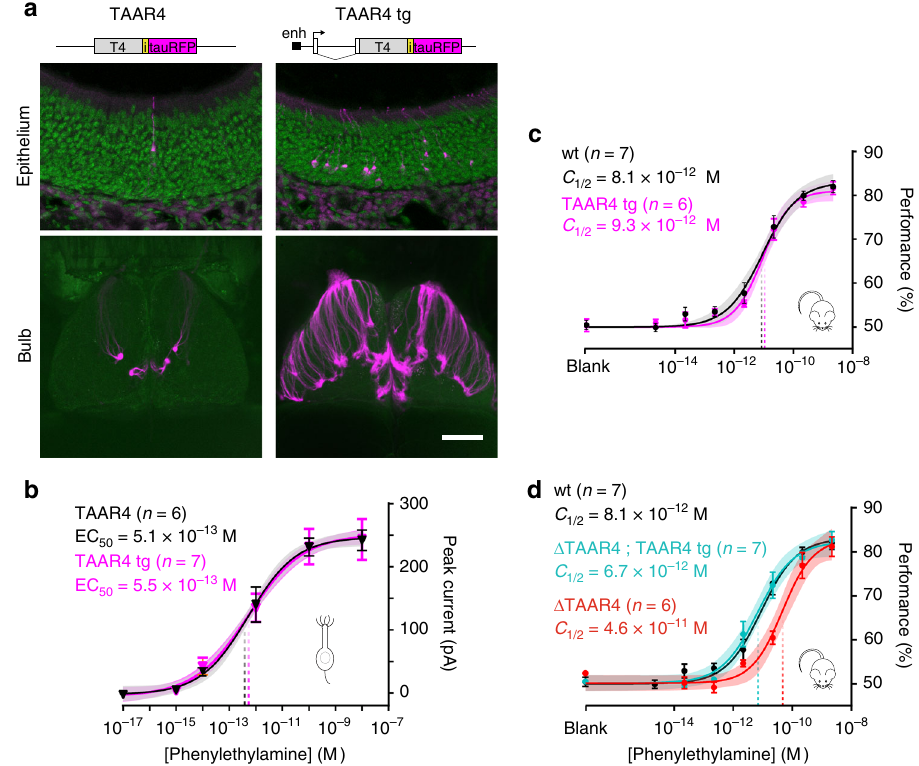
Fig. 6 Overexpression of a threshold-determining TAAR does not enhance behavioral sensitivity. a Top: summary of transgenic strategy showing the control gene-targeted TAAR4 locus and transgene. The M71 transgene was modi fi ed by inserting a 5× homeodomain enhancer (enh) upstream of the transcription start site and by replacing the M71-coding sequence with the TAAR4-coding sequence, an internal ribosome entry site (i), and a fl uorophore (tauRFP). Bottom: Sections of the olfactory epithelium and whole mounts of the olfactory bulb (dorsal view) in TAAR4-RFP and transgenic overexpressing mice. Scale bar is 50 μ m in upper panels and 800 μ m in lower panels. b Dose – response curves of OSN responses to phenylethylamine. Peak inward current was measured from single labeled neurons from TAAR4-RFP (black) and TAAR4 transgenic (magenta) mice. T4-RFP EC 50 = 5.1 × 10 − 13 M (95% CI = 3.0 – 8.3 × 10 − 13 M). 5×21-TAAR4Tg EC 50 = 5.5 × 10 − 13 M (95% CI = 2.5 – 11.6 × 10 − 13 M). c No effect of transgene expression on phenylethylamine sensitivity. Psychometric curves showing behavioral sensitivity ( C 1/2 ) of TAAR4 overexpressing transgenic mice (magenta) and wild-type littermates (black) to phenylethylamine. wt C 1/2 = 8.1 × 10 − 12 M (95% CI: 4.6 – 16.8 × 10 − 12 M), 5×21-TAAR4Tg C 1/2 = 9.3 × 10 − 12 M (95% CI: 6.0 – 15.9 × 10 − 12 M). d Effective transgenic rescue. Psychometric curves showing C 1/2 of Δ TAAR4 mice (red) and Δ TAAR4 mice with the TAAR4 transgene (cyan) littermates. Wild-type (black) pyschometric curve is replotted from c . Δ T4 C ½ = 4.6 × 10 − 11 M (95% CI = 2.4 – 13.0 × 10 − 11 M), Δ T4 ; 5×21-TAAR4Tg C ½ = 6.7 × 10 − 12 M (95% CI = 3.3 – 15.3 × 10 − 12 M). Plots show mean + / − SE with a shaded 95% con fi dence